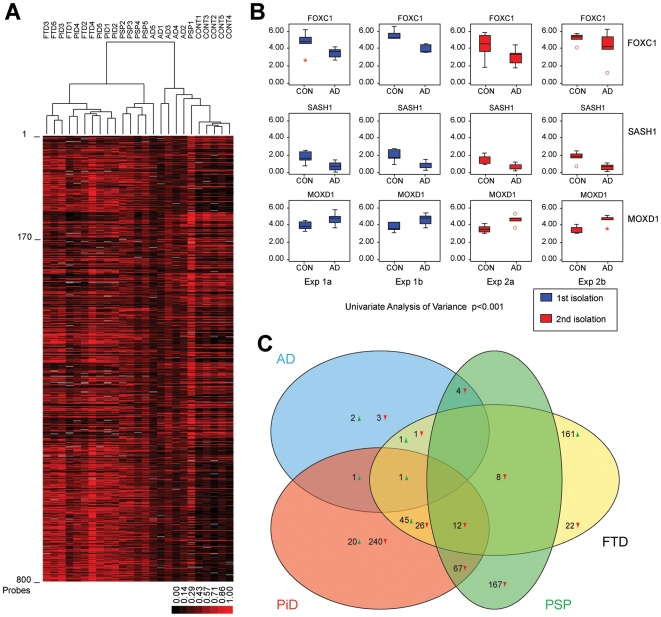
Initial analysis and confirmation of the microarray data.
Figure 1A. Clustering of all 25 samples using the background filtered dataset of 790 probes. Figure 1B. Results of quantitative PCR experiments for 3 genes (FOXC1, SASH1 and MOXD1) that were significantly differently expressed in Alzheimer's disease vs. controls. Experiments were done in duplo (a and b) using cDNA from two separate isolations of the same brain sample (Exp 1 and 2). Statistical testing was done using a Univariate Analysis of Variance with p<0.001 in all samples. Similar results were observed in the other tested illnesses. Figure 1C. Graphical overview of probes and their correlation between pathology defined groups. Amount of up- and down-regulated probes is shown with up- or downwards facing arrowheads. Pathology defined groups are represented as coloured ellipses; Alzheimer's disease (AD): blue, Pick's disease (PiD): red, Frontotemporal dementia (FTD), yellow and Progressive Supranuclear Palsy (PSP): green.